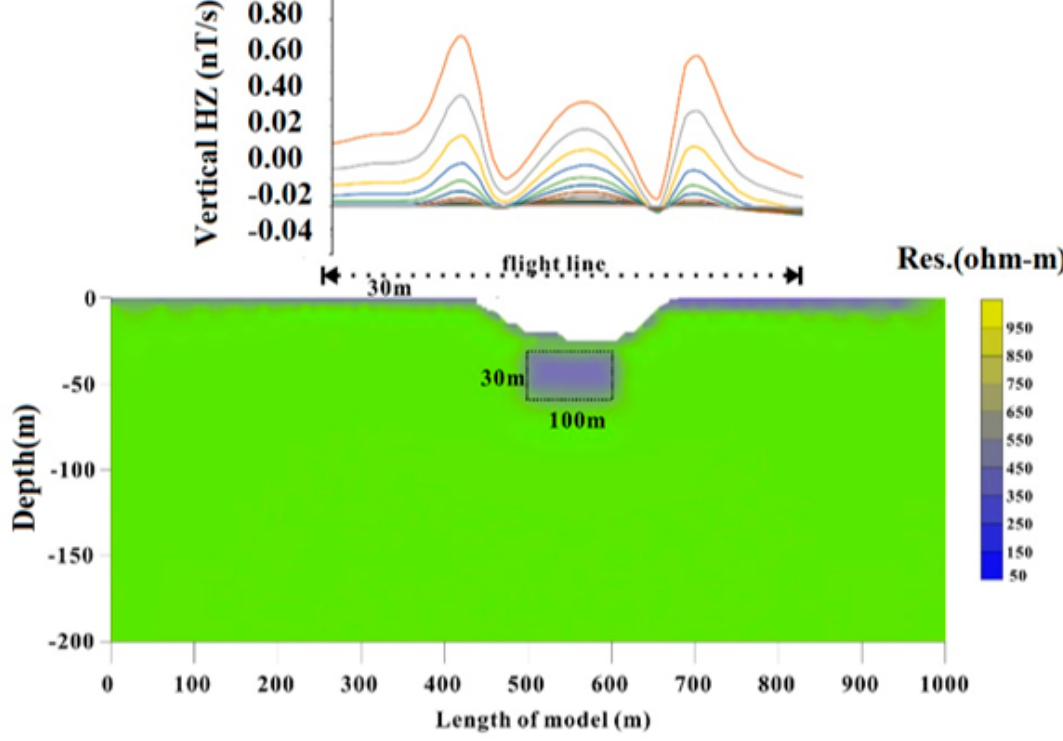
Figure 5. Geo-electrical model with terrain and the forward modelling results.